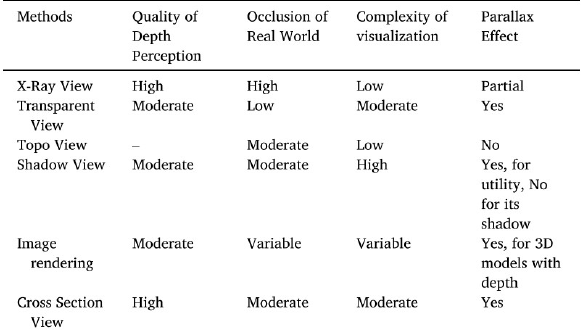
Figure 7. Shadow of a utility